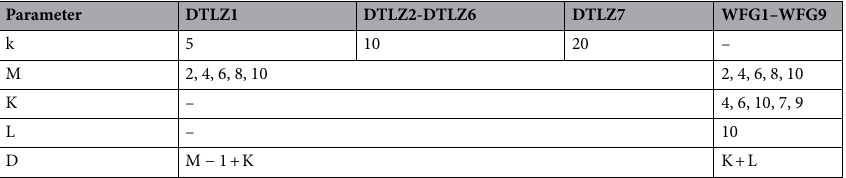
Table 1. Parameter settings for DTLZ and WFG test suites. K DTLZ problem specific parameter, M number of objectives, K position vector, L distance vector, D number of